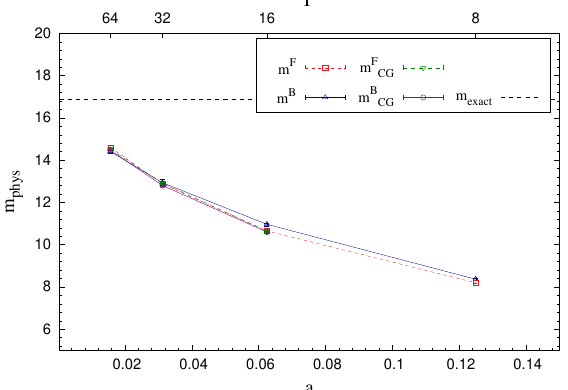
and m F , respectively represent bosonic and fermionic CG CG